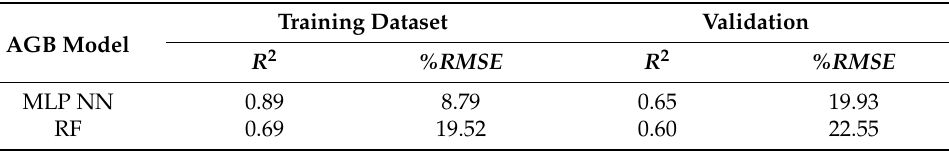
Table 5. Training and validation results of the aboveground biomass (AGB) using the MLP NN and RF